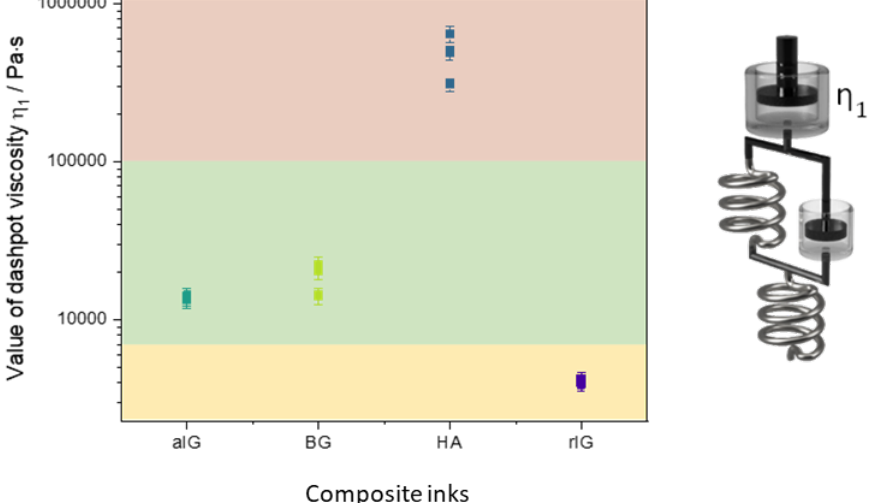
Figure 12. Illustration of the resulting windows of processability according to η 1 obtained by the augmented Burgers model for the different inks investigated.